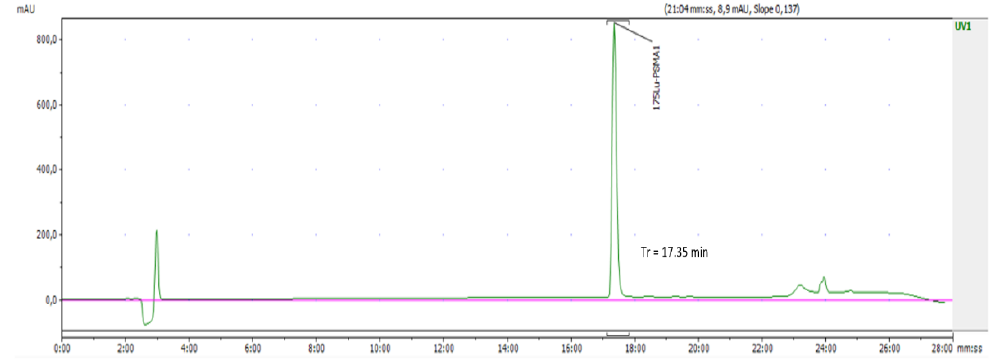
Figure 1. Retention time of the 175 Lu-PSMA I/T standard.